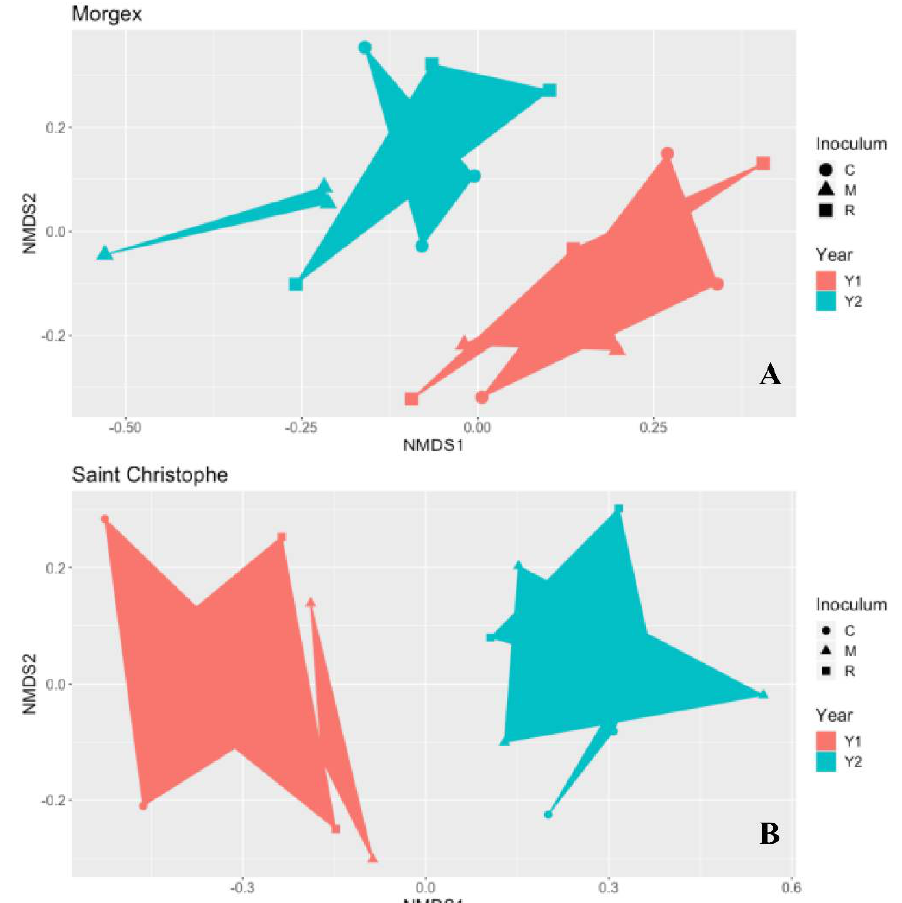
Figure 4. Ordination plots (NMDS) showing beta diversity of fungal communities of Morgex ( A ) and Saint Christophe ( B ). The two fungal communities are significantly affected by the sampling time (Y1; Y2) ( p ≤ 0.05, Permanova; Bray–Curtis) but not by the inoculum (C = Carrier Control; R = Single-species inoculum (Rhizophagus intraradices); M = Multi-species inoculum (R. intraradices and Funneliformis mosseae).